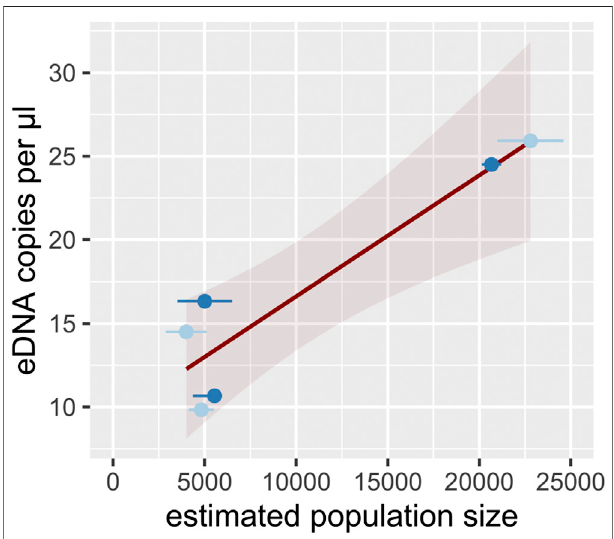
FIGURE 4 | eDNA concentration within populations (median per sampling site) in relation to estimated upstream population size. Trend line is givenbylinearregression( R 2 (cid:1) 0.83, p < 0.01,red-shadedarearepresentsthe 95% con fi dence interval). Light-blue and dark-blue dots represent populationsof A.pallipes and A.torrentium ,respectively.Horizontalerrorbars indicate the lower and upper 95% CI for the population